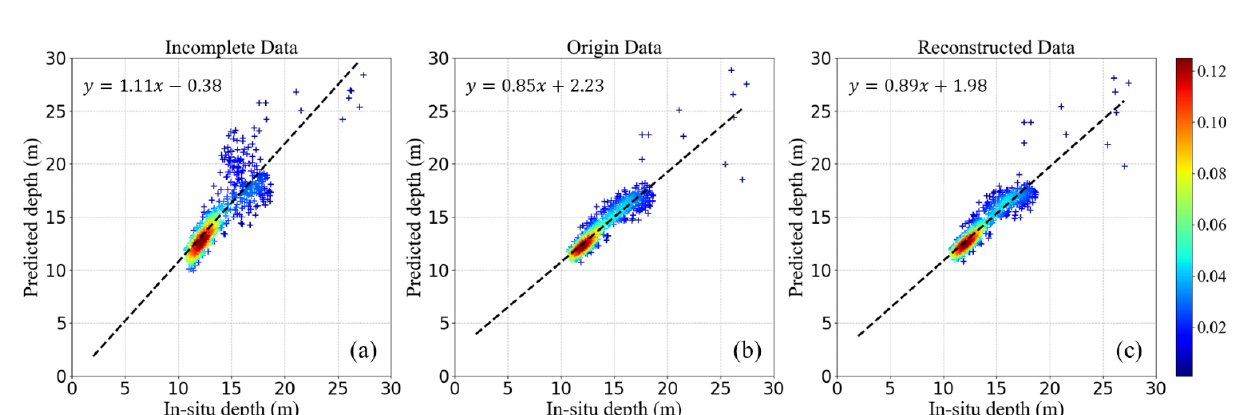
Figure 13. Scatterplots of water depth inversion in the local study area based on three sets of training data: ( a ) results based on incomplete data, ( b ) results based on complete original data, and ( c ) results based on reconstructed data.